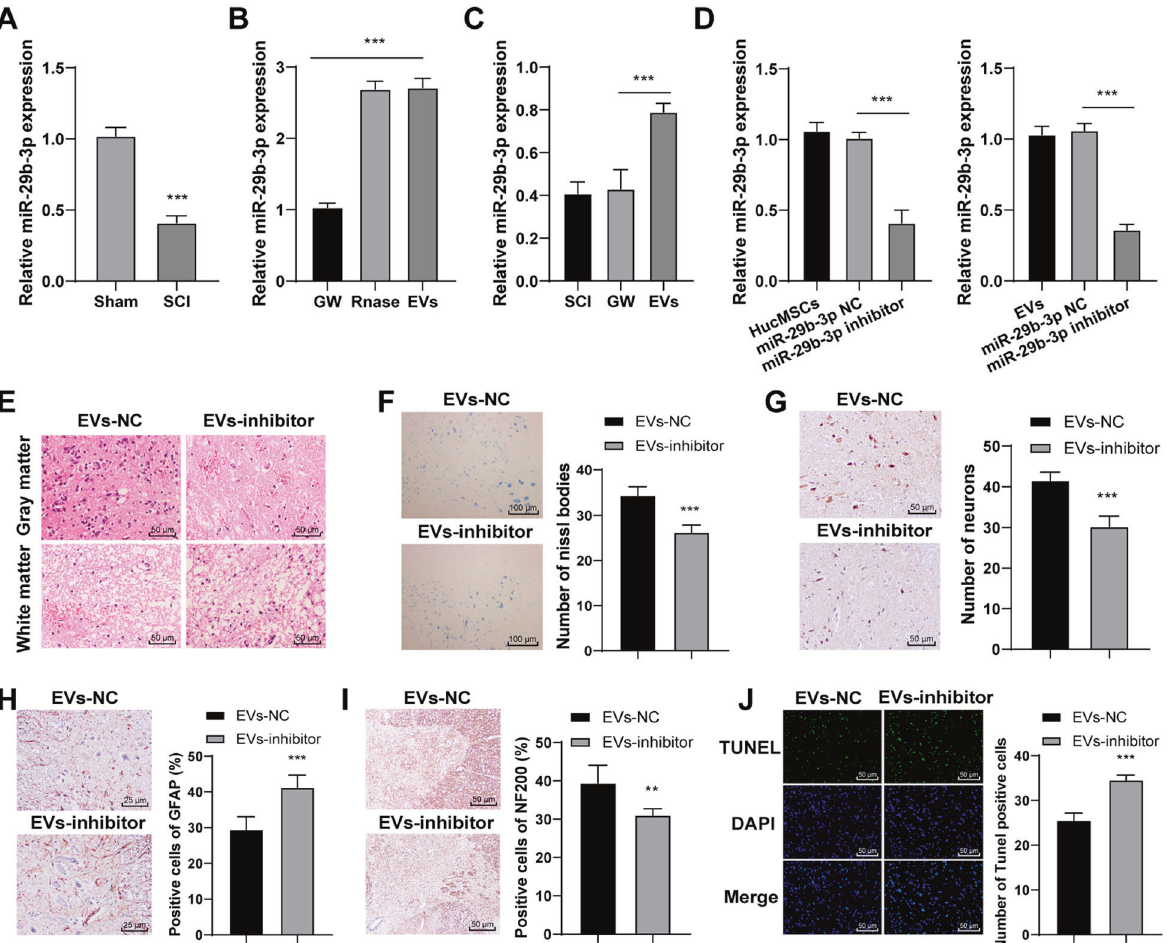
Fig. 4 HucMSCs-EVs repair SCI in rats by carrying miR-29b-3p. A miR-29b-3p expression in spinal cord tissues of SCI rats was detected using RT-qPCR on the 28th day after operation. B miR-29b-3p expression in EVs was detected using RT-qPCR. C miR-29b-3p expression in spinal cord tissues of EVs-treated SCI rats was detected using RT-qPCR on the 28th day after the operation. D miR-29b-3p expression in miR-29b-3p inhibitor-treated HucMSCs and EVs was detected using RT-qPCR. E pathological changes were measured using HE staining. F Nissl bodies were detected using Nissl staining. G – I Expressions of NeuN, GFAP, and NF200 were detected using immunohistochemistry. J Apoptosis in spinal cord tissues of SCI rats was detected using TUNEL. N = 6. Data are expressed as mean ± standard deviation and analyzed using t -test or one-way ANOVA, followed by Tukey ’ s multiple comparisons test, ** p < 0.01, *** p <